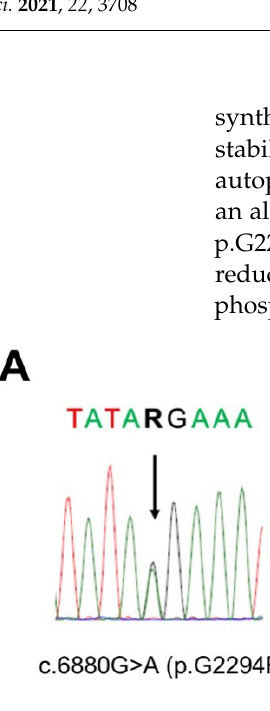
Figure 1. PD case with LRRK2 p.G2294R and her family pedigree. ( A ) Sanger sequencing found a heterozygous missense variant, NM_198578.4: c.6880G > A (p.G2294R). A, Adenine; T, Thymine; G, Guanine; R, purine (A or G). ( B ) The family pedigree of a patient with LRRK2 p.G2294R. Black arrow, proband; square, male; circle, female; oblique line, deceased; black-colored circles, clinically diagnosed with PD. II-4 and II-6 were monozygotic twins. II-8 was not assessed by genetic testing.